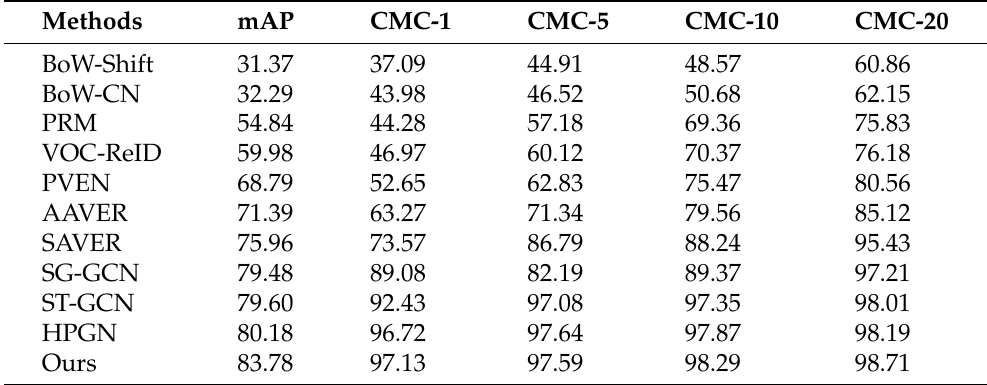
Table 3. Comparisons results(%) of object Re-ID on VeRi-776 dataset by using the metrics of mAP, CMC-1, CMC-5, CMC-10 and CMC-20,